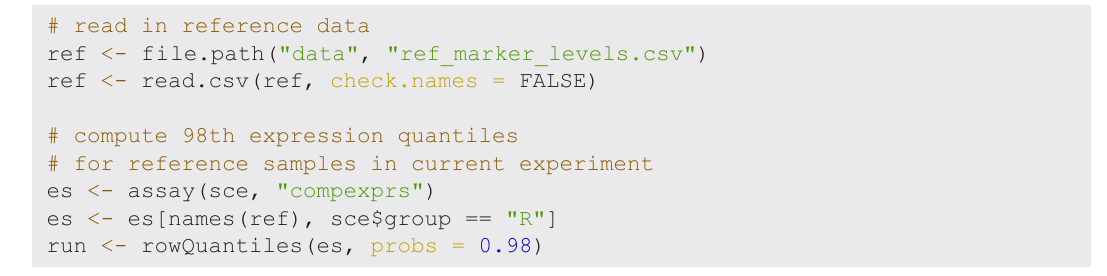
QC on mean marker intensities As the third and final quality control, we compare the 98th expression quantiles across all targets of inter- est over the pooled references to those obtained from 7 previously acquired experiments available in metadata table (Figure 16). We chose the 98th percentile to account for the fact that some ref_marker_levels.csv populations are rare, and we are particularly interested in assessing signal stability for positive cells rather than the median of the population. Since the pooled references are identical from one experiment to another, this gives a direct indication of the current experiment’s staining efficacy and enables early identification of antibody degradation over